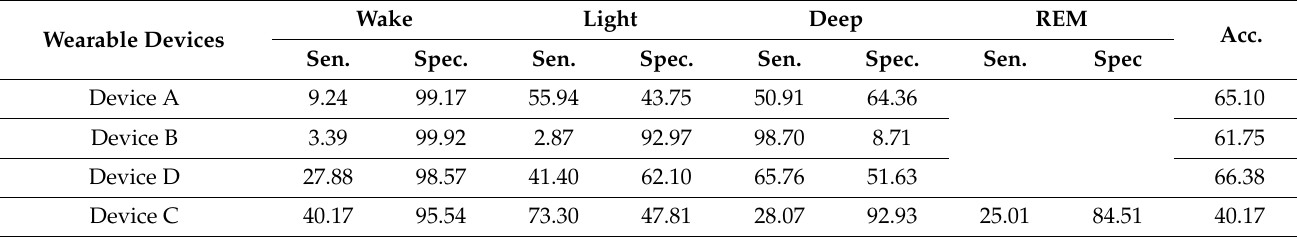
Table 8. Confusion matrix of epoch-by-epoch comparison among the four wearable devices and the PSG’s hypnograms for the four sleep stages of Wake, Light, Deep, and REM.